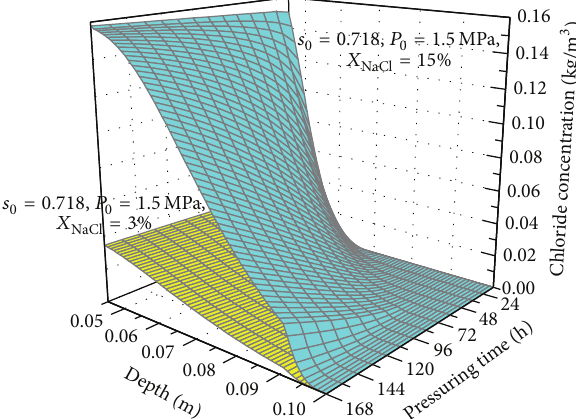
Figure 9: Chloride concentration simulation under different solu- tion concentration.